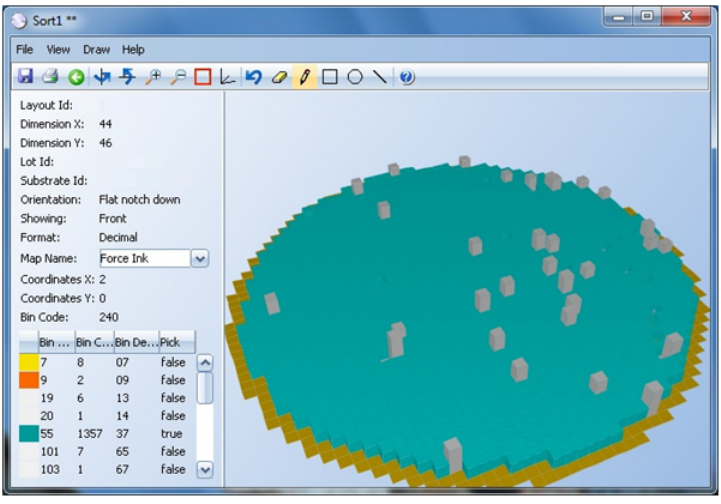
Figure 3. Hard bin 3D wafer view.